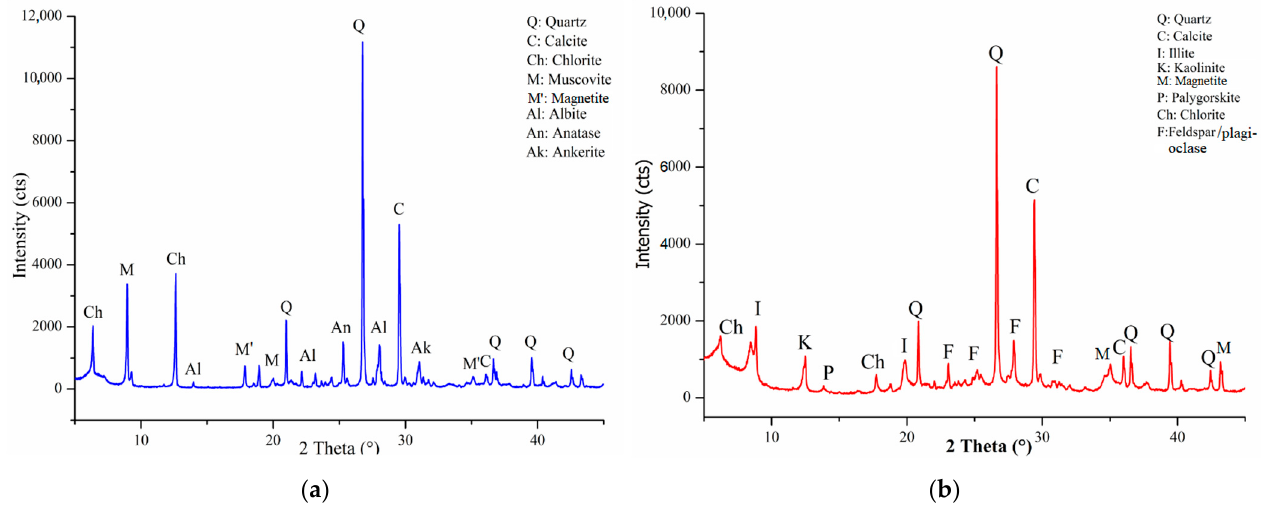
Figure 4. The X-ray patterns of gold mine waste rocks (GMWRs) ( a ) and natural clay (NC) ( b ).